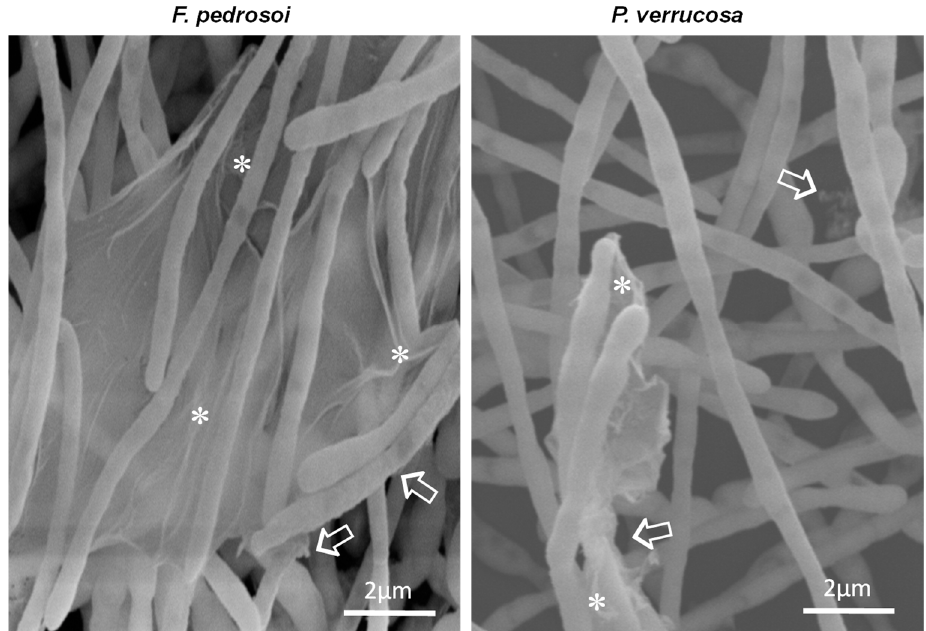
Figure 6. High-magnification SEM images of fungal biofilm on a polystyrene surface. The representative images show the extracellular matrix around the hyphal cells (white arrows) and also acting as glue that holds the hyphae attached (asterisks).